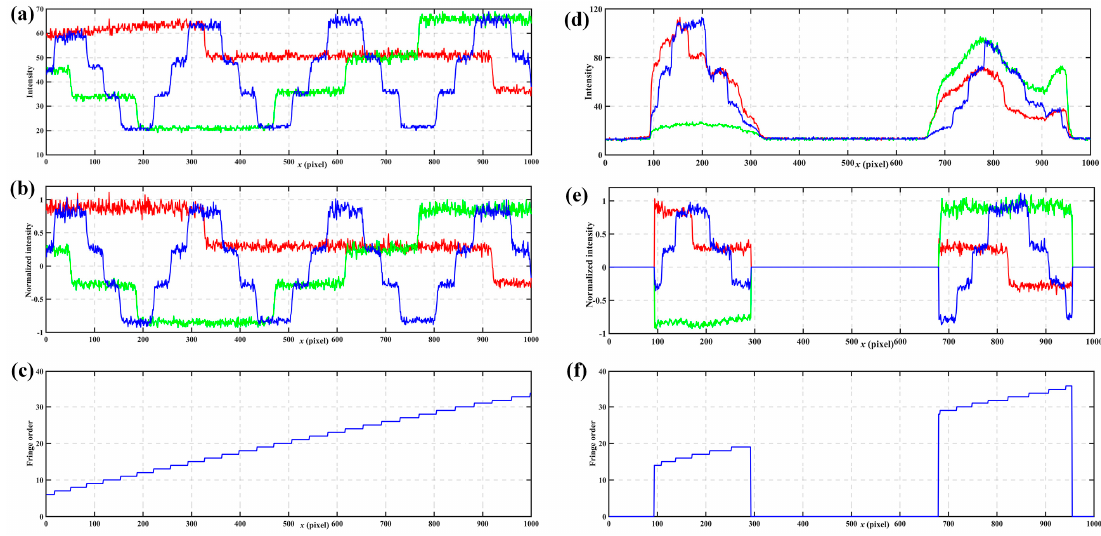
Figure 11. One cross-section of the n GC method. ( a ) n GC patterns without normalization of the reference plane, and ( b ) the same patterns after normalization, ( c ) fringe orders calculated from the normalization patterns for the reference plane, ( d ) n GC patterns without normalization of the measured objects, and ( e ) the same patterns after normalization, and ( f ) fringe orders calculated from the normalization patterns for the measured objects.